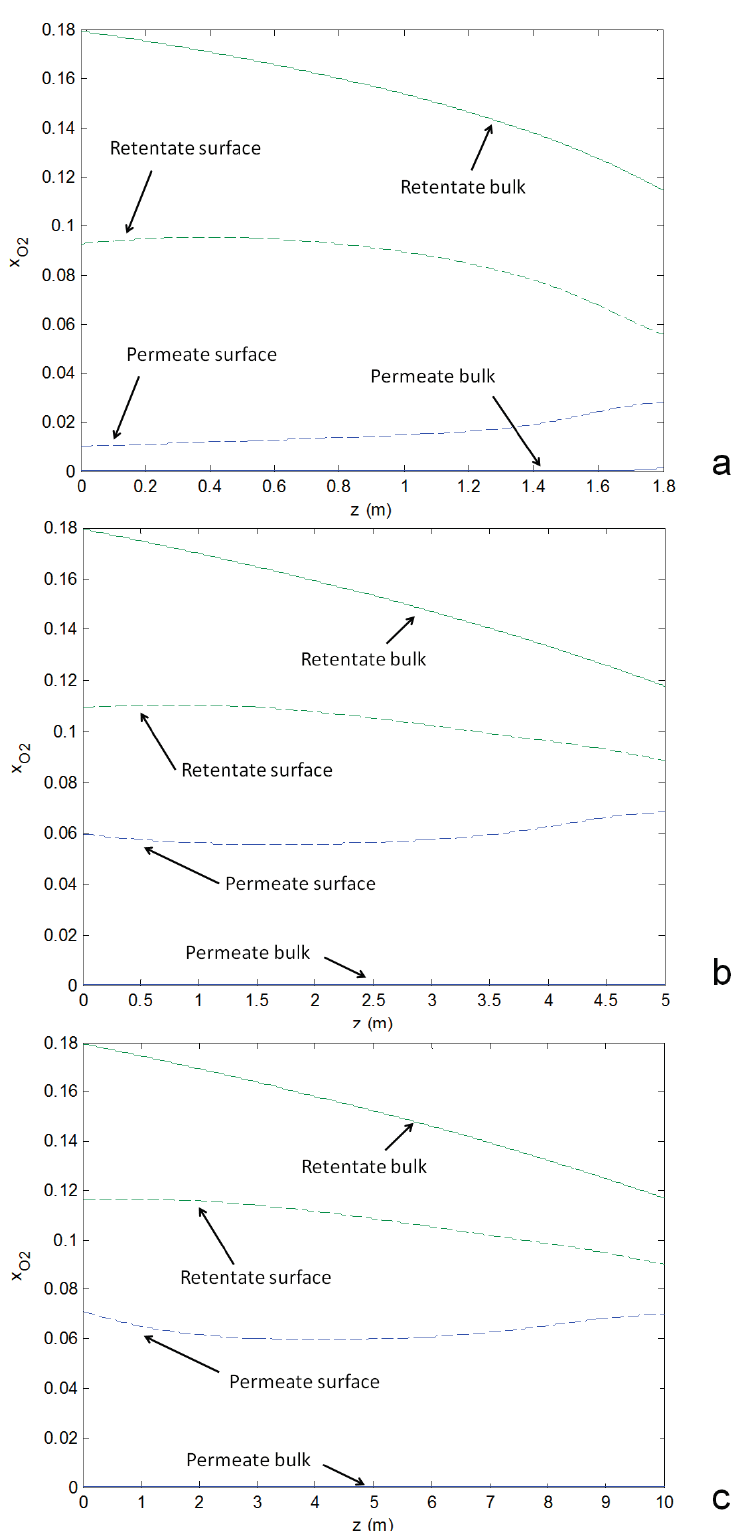
Figure 7. Oxygen volume fraction profiles along the reactor of the gas streams and the membrane surface. ( a ) small size reactor; ( b ) medium size; ( c ) big size reactor. Continuous lines are related to the bulk phase and dashed lines are related to the membrane surface at retentate (green) and permeate (blue)